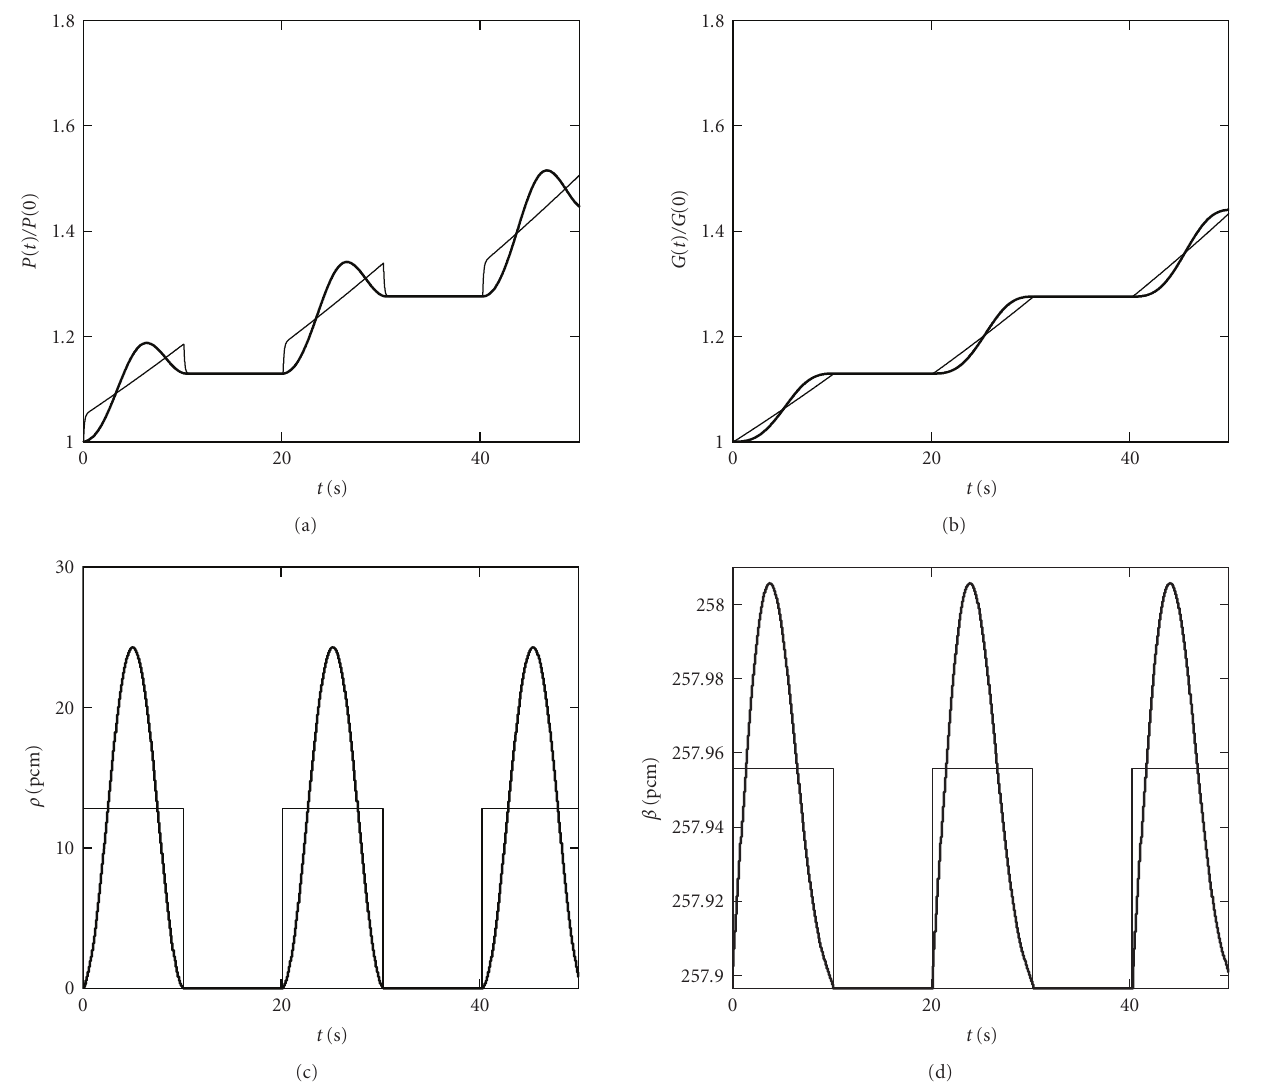
Figure 3: Behavior of the total power (a), neutron delayed precursor concentration (b), reactivity (c), and e ff ective fraction of delayed neutrons (d) during the transit a fissile of lump along the axis of a critical system. The di ff erent curves in the graphs are associated to the di ff erent models adopted: real reactivity injection (bold line), square wave approximation (thin